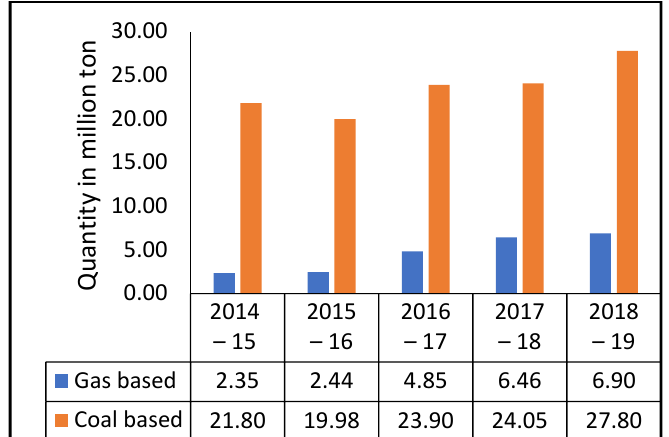
Figure 6. DRI Production (Graph plotted using data from: Ministry of Steel).